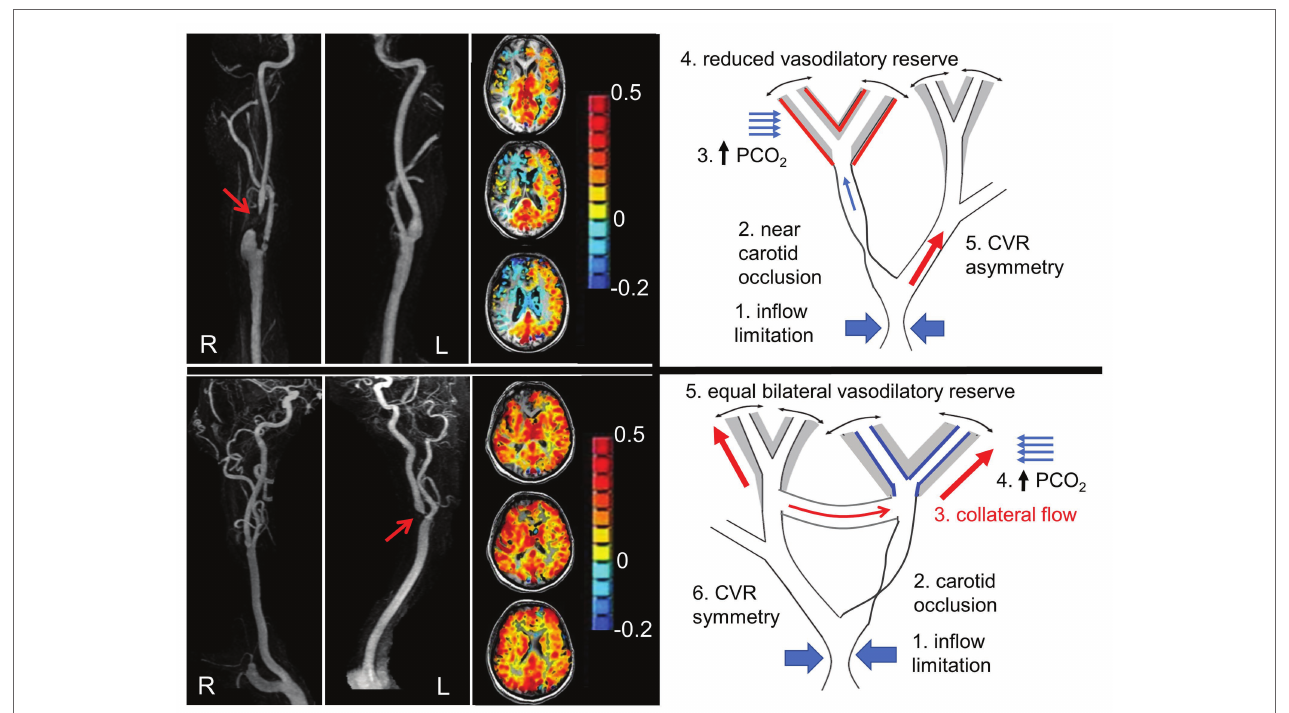
FIGURE 2 | Pathophysiology of steal, and steal as a marker of availability of collateral flow. Left panel shows angiograms from two patients with nearly occluded carotid arteries (red arrows). Next to each are axial slice cerebrovascular reactivity (CVR) maps from the hypercapnic test. The CVR for each voxel is color coded according to the color scheme shown and mapped onto the corresponding voxel of the anatomical scan. The upper panel shows steal physiology (blue voxels on axial scan), and the lower panel shows near normal CVR. The suggested mechanism of each map is shown in the schematic to the right. Upper right panel : (1) Flow capacity of intracranial vessels greater than can be supplied by extracranial vessels depicted as “inflow limitation”; (2) occlusion of a branch; (3) hypercapnia and stimulation of vasodilation; (4) vasodilatory reserve (gray area) is exhausted downstream from the occlusive lesion (indicated by the red lines on the outside of the gray zone), but intact on the contralateral side (indicated by black lines inside gray zone); and (5) with hypercapnia, flow is directed predominantly to the contralateral side, dropping the perfusion pressure at the bifurcation. The reduced perfusion pressure reduces the flow downstream from the lesion. In the lower right panel : (1) Collateral flow bypasses the stenotic lesion. Both sides retain flow reserve. A hypercapnic stimulus results in bilateral positive CVR. Modified from Hoiland et al.